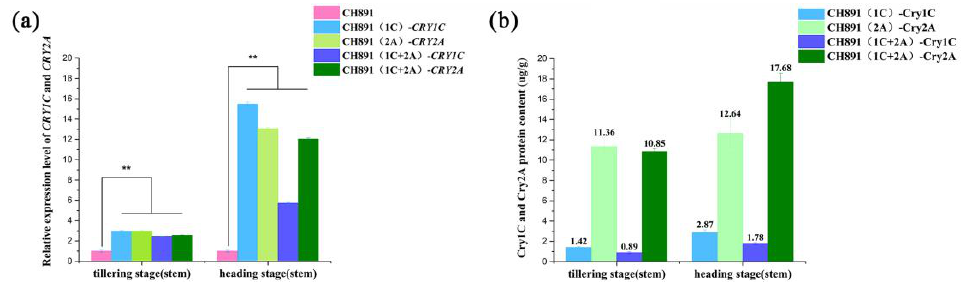
Figure 4. Comparison of a recurrent parent (CH891) with CH891(1C), CH891(2A), and CH891(1C+2A) transgenic restorer lines that consisted of CRY1C, CRY2A , and both CRY1C / CRY2A genes, respectively. ( a ). Relative gene expression levels of CRY1C and CRY2A based on qRT-PCR. ( b ). Cry1C and Cry2A protein content was detected by enzyme-linked immunosorbent assay (ELISA). Data of each test were analyzed by one-way ANOVA (** p < 0.01).